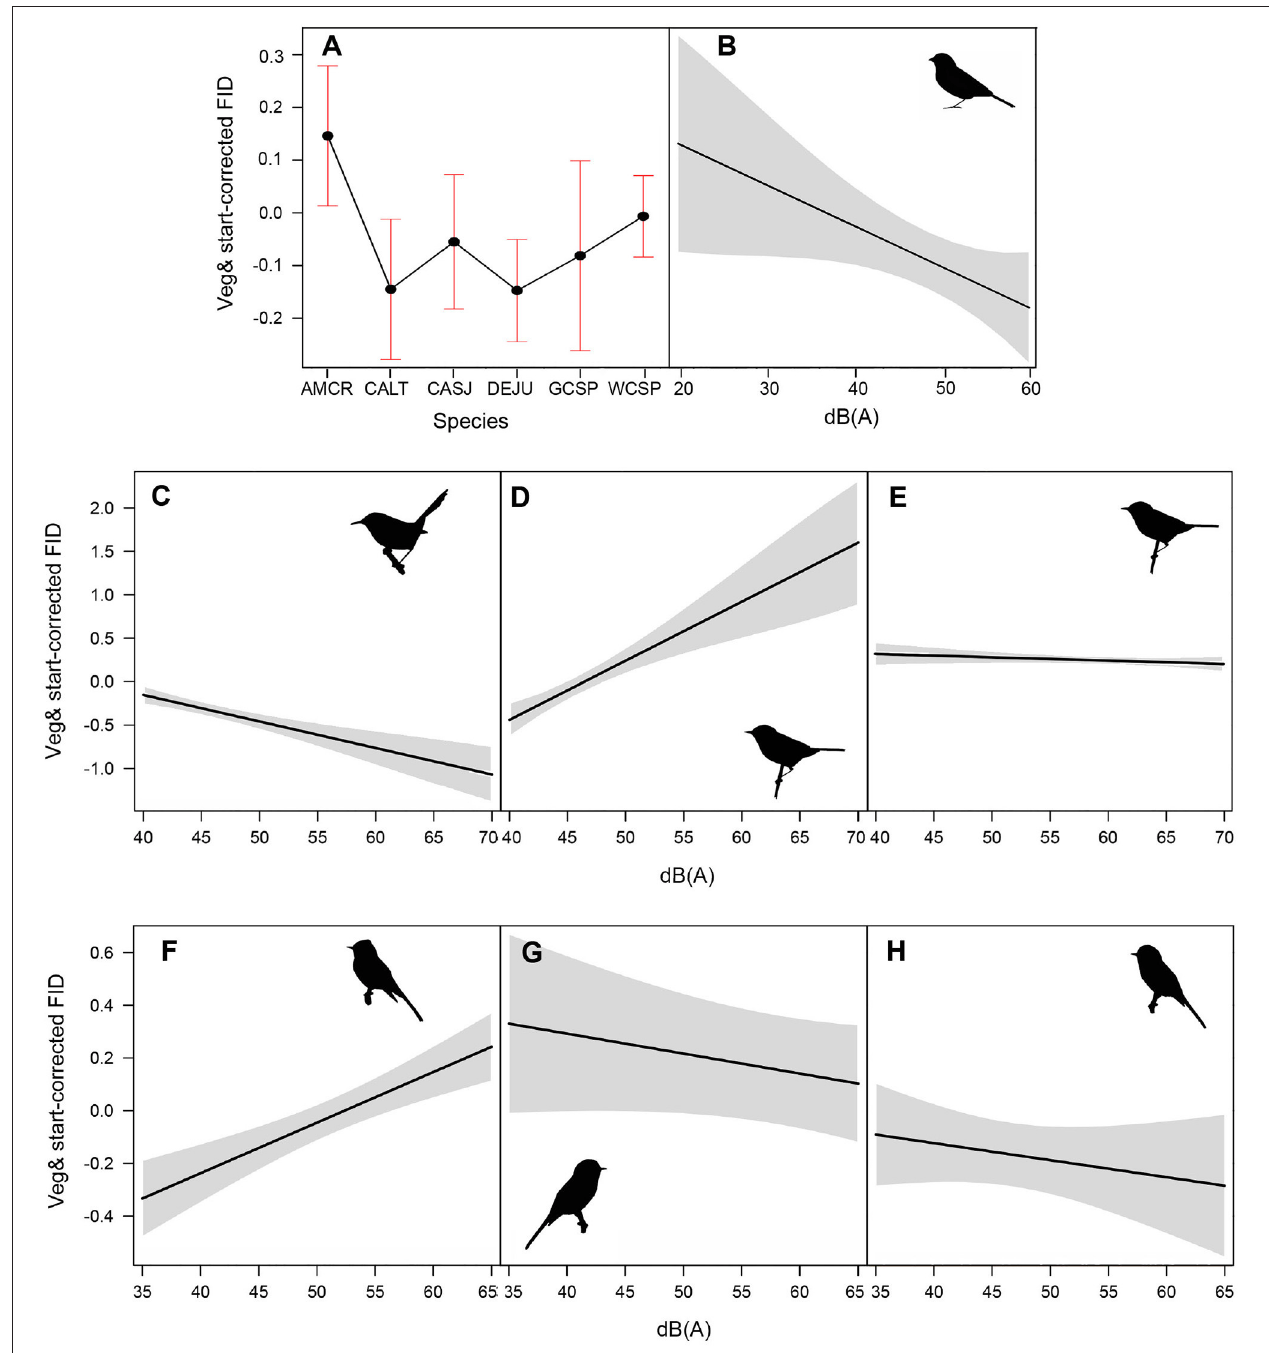
FIGURE 2 | (A) illustrates mean adjusted FID and standard error for each species in the ground foraging guild. Species depicted are American crow (AMCR), California towhee (CALT), California scrub jay (CASJ), dark-eyed junco (DEJU), golden-crowned sparrow (GCSP), and white-crowned sparrow (WCSP). (B–H) illustrate the influence of ambient noise on vegetation and start distance-corrected FID values for all ground foraging species (B) , canopy gleaning species Pacific wren (C) , Wilson’s warbler (D) , yellow warbler (E) , and flycatching species black phoebe (F) , dusky flycatcher (G) , and Pacific-slope flycatcher (H) . For plotting purposes, we utilized the top-ranking model (lowest AICc and fewest parameters) for each of the foraging guilds ( Table 2 ).